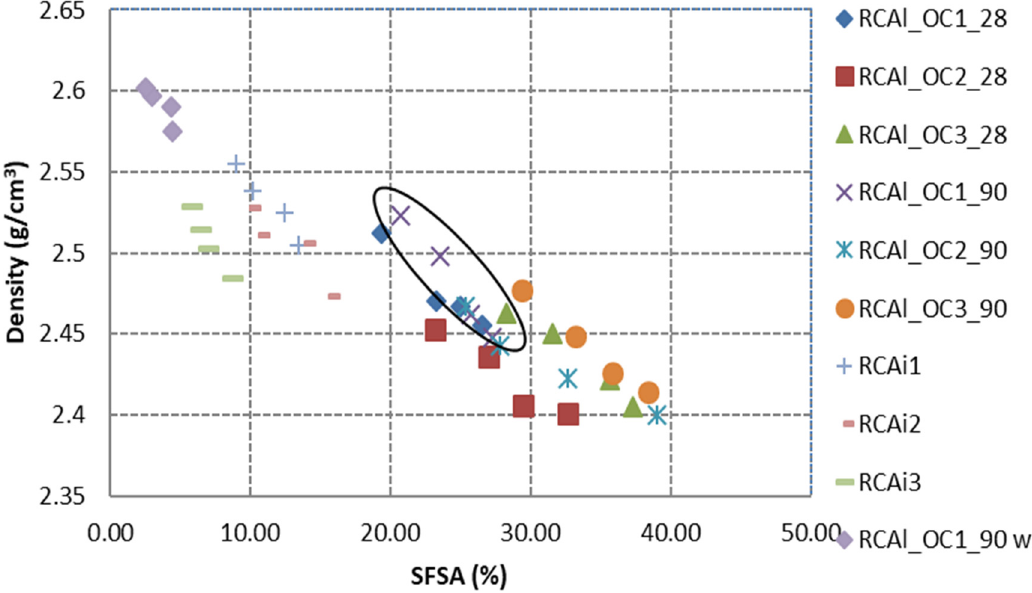
Figure 10. Correlation between specific density and SFSA in RCA.